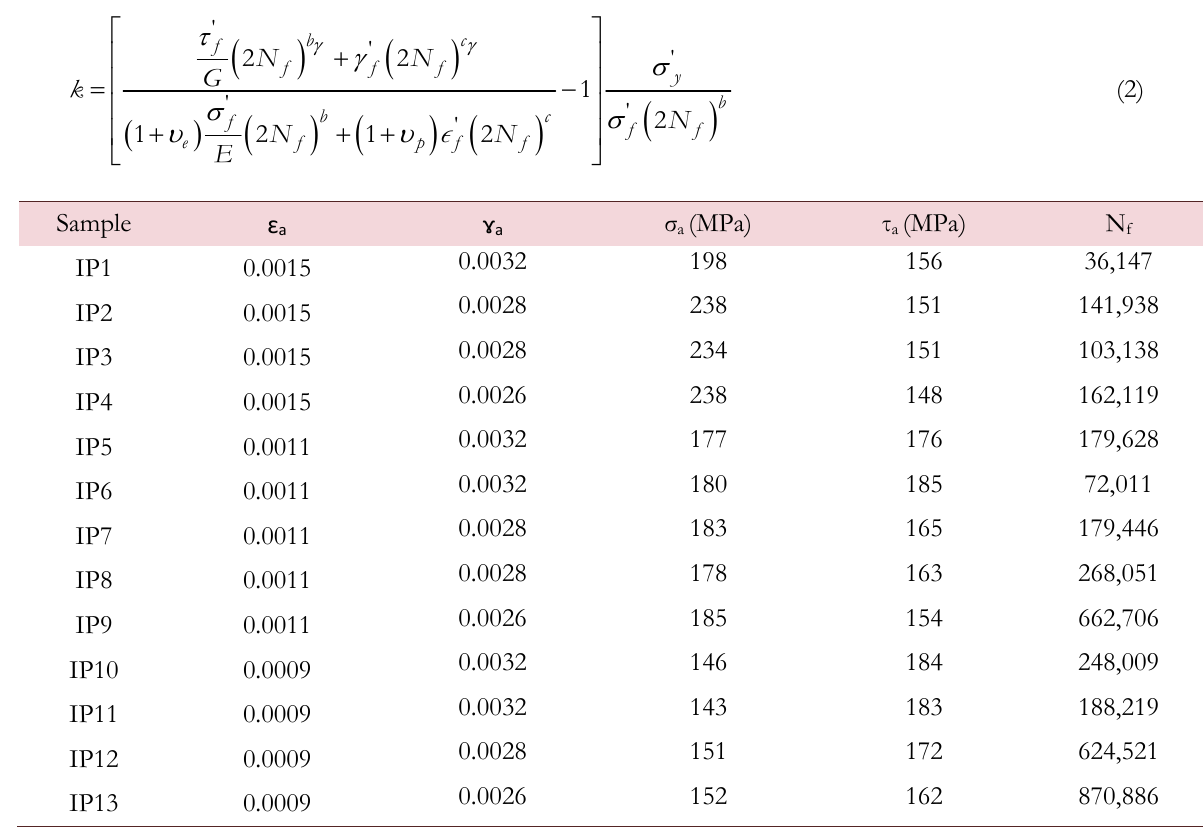
Table 4: Strain and stress conditions for in-phase strain conditions and the obtained fatigue life in number of cycles. Suman & Kallmeyer damage parameter